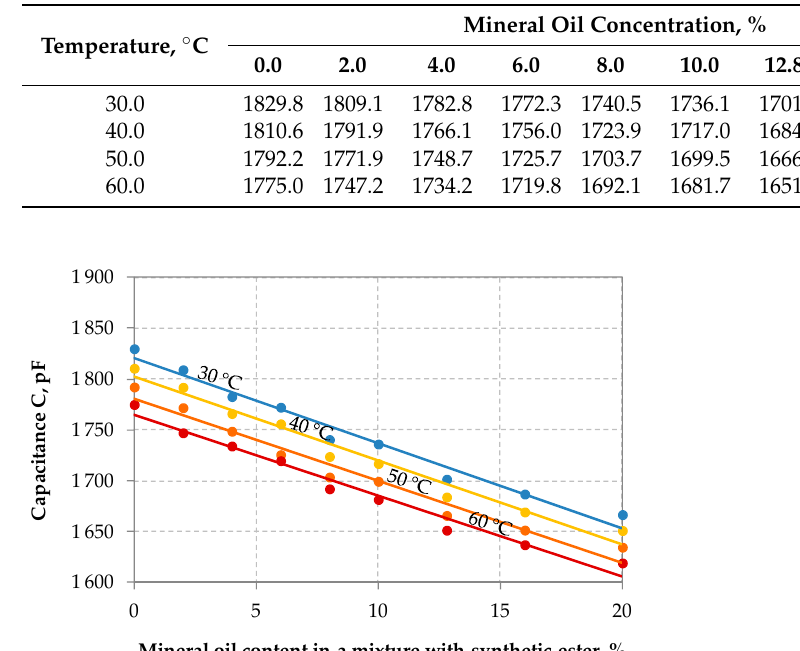
Table 4. Values of parameters a and b depending on temperature calculated based on data presented in Figure